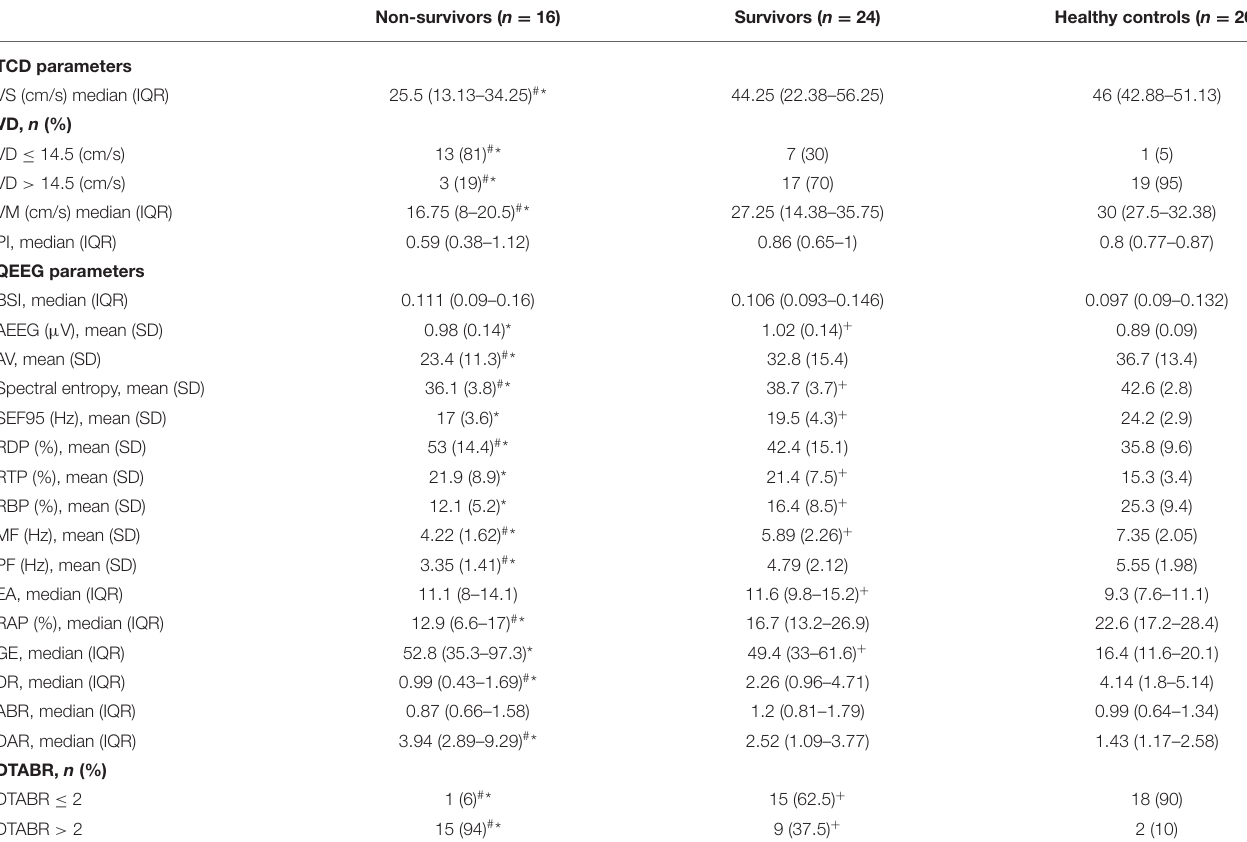
TABLE 2 | Transcranial Doppler and quantitative electroencephalographic